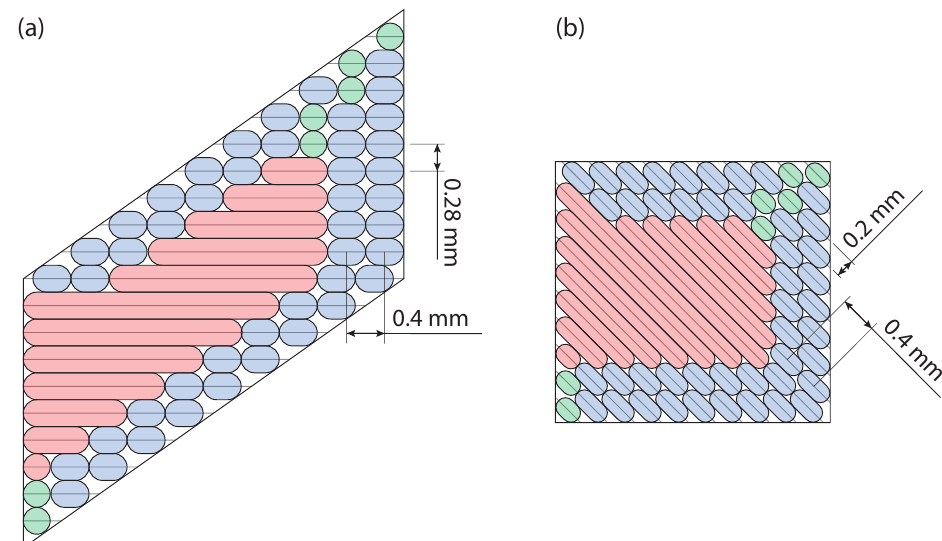
Figure 8. Section through a sliced object (simplified). The sliced part in the transformed state ( a ) and the part after the G-code is transformed with T − 1 ( b